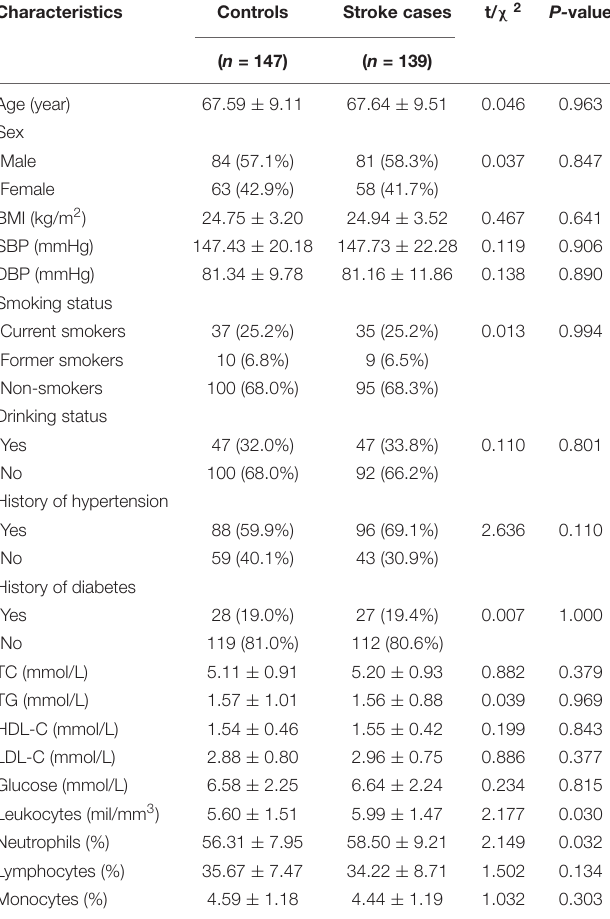
TABLE 1 | Demographic and clinical characteristics of participants in the nested case-control study.